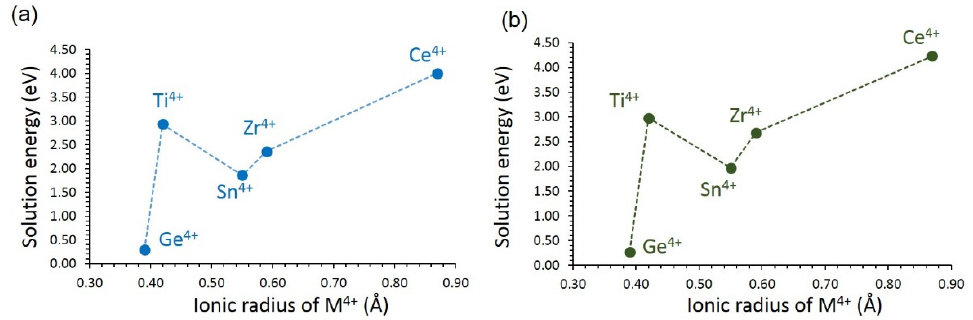
Figure 10. Solution energy of MO 2 with respect to the M 4+ ionic radius in ( a ) LiVSi 2 O 6 and ( b ) NaVSi 2 O 6 .